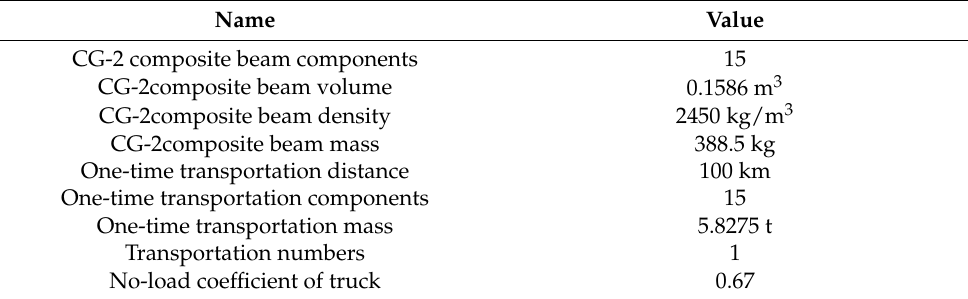
Table 5. Relevant parameters of CG-2 composite beams during the transportation stage.